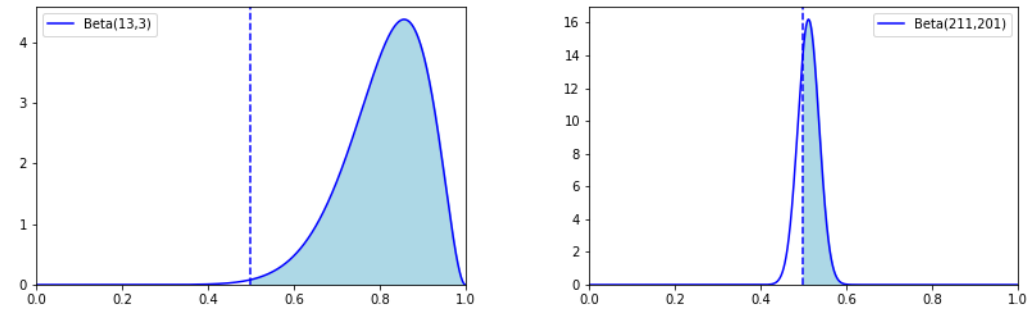
Figure A2. The probability distributions corresponding to the Case (a) ( left ) and Case (b) ( right